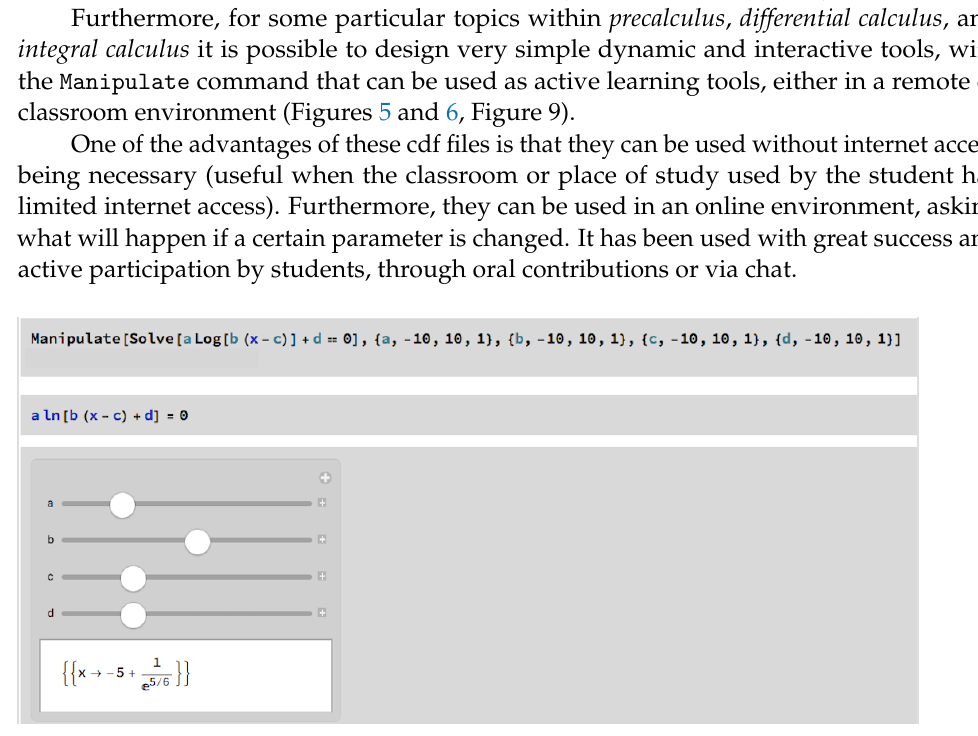
Figure 5. Image with a dynamic and interactive tool to solve